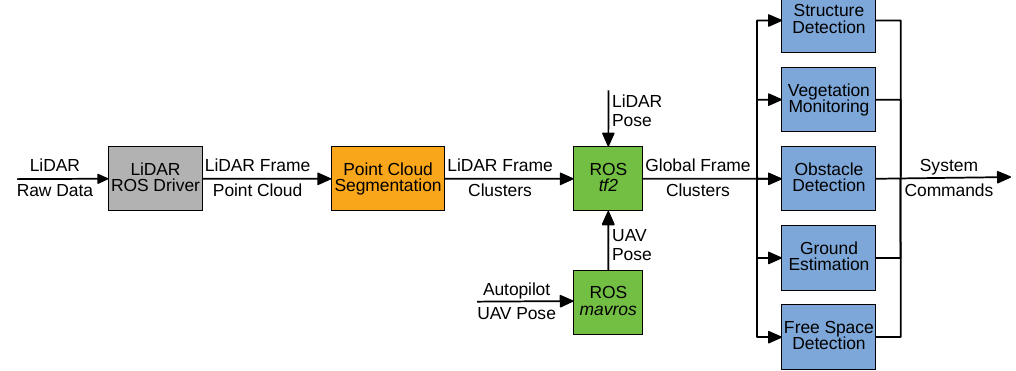
Figure 2. High-level software